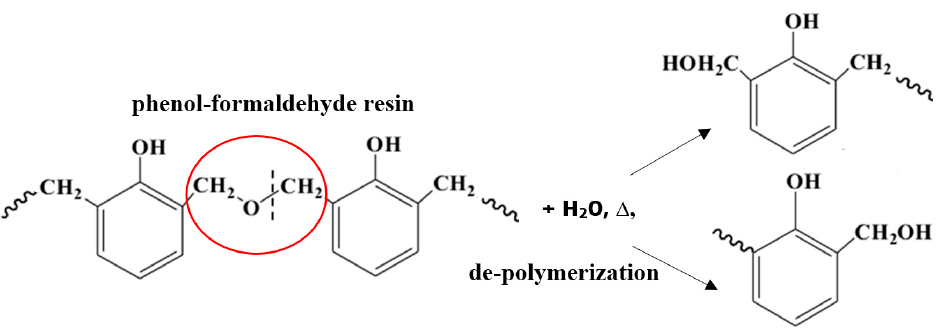
Figure 4. Partial degradation of resin by depolymerization initiated by hydrolysis.